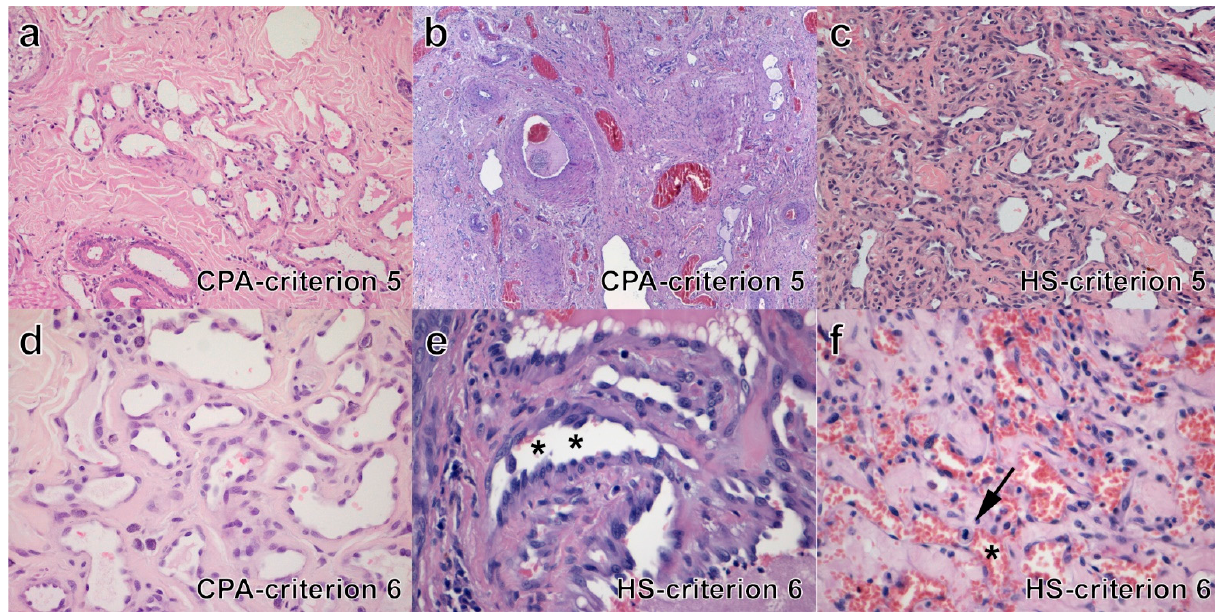
Figure 3. Histopathology in cases of CPA and HS (H&E stain): criteria 5 and 6. ( a ) CRITERION 5, CPA, case n. 11: combinations of small veins, arteries and lymphatics; ( b ) CRITERION 5, CPA, case n. 27: combination of different type and sized vessels; ( c ) CRITERION 5, HS, case n. 10: channels of newly formed abnormal vascular structures; ( d ) CRITERION 6, CPA, case n. 3: flat and only focally plump endothelial lining; ( e ) CRITERION 6, HS, case n. 11: prominent endothelial lining with occasional piling up (asterisks); ( f ) CRITERION 6, HS, case n. 3: cytological atypia of the endothelial lining and one mitotic figure (asterisk).